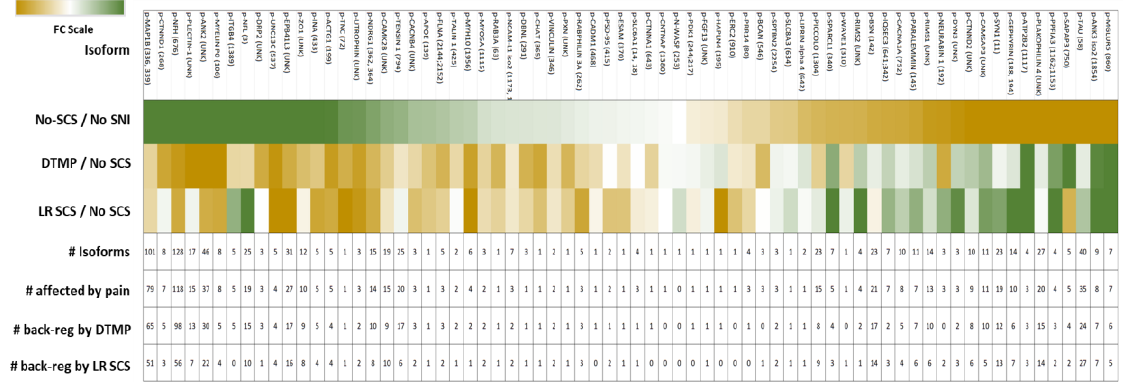
Figure 5. Heat map with expression level fold changes (FC) of selected phosphoproteins isoforms associated with cell junction at the ECM. Isoforms with the largest expression change due to the pain model are shown for each phosphoprotein. Values in the table below the heat map indicate the number of isoforms identified, how many were affected by the pain model and how many of these were back-regulated (back-reg) by DTMP or LR SCS.